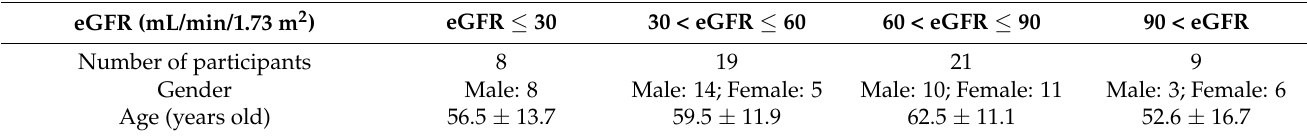
Table 1. The four groups of participants with different eGFR